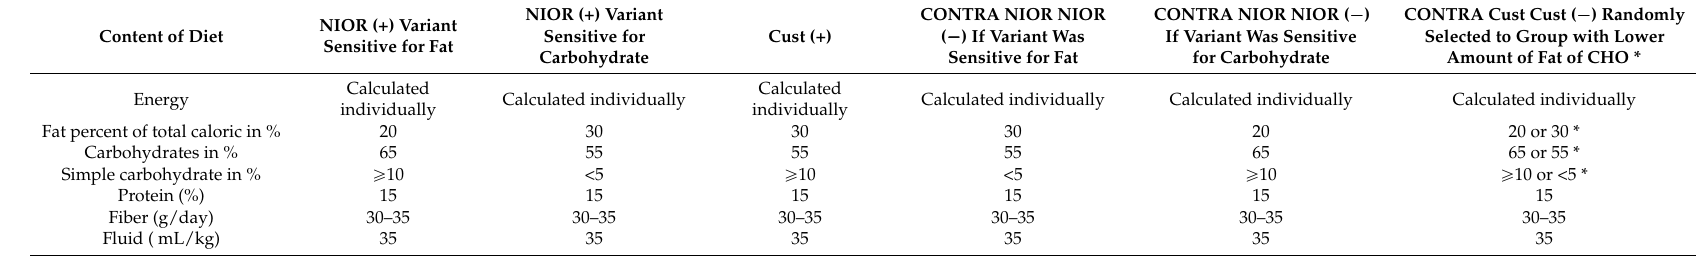
Table 2. Characteristics of dietary interventions. Nutrient-induced insulin output ratio (NIOR) (+) represents individuals consuming a diet consistent with the results of genotyping; Cust (+), individuals consuming a diet comprising the typical dietary recommendations for non-alcoholic fatty liver disease (NAFLD); NIOR ( ´ ) and Cust ( ´ ), individuals consuming a diet contrary to the genotyping results. * Group with a lower amount of carbohydrate (CHO) or